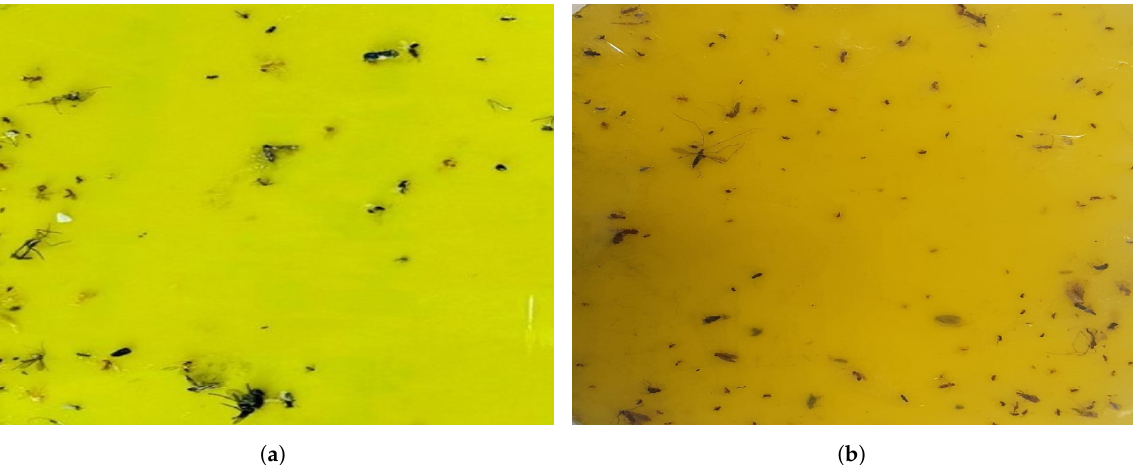
Figure 9. Real-time mosquito glue trap ( a ) Glue Trap 1 (Morning) ( b ) Glue Trap 2